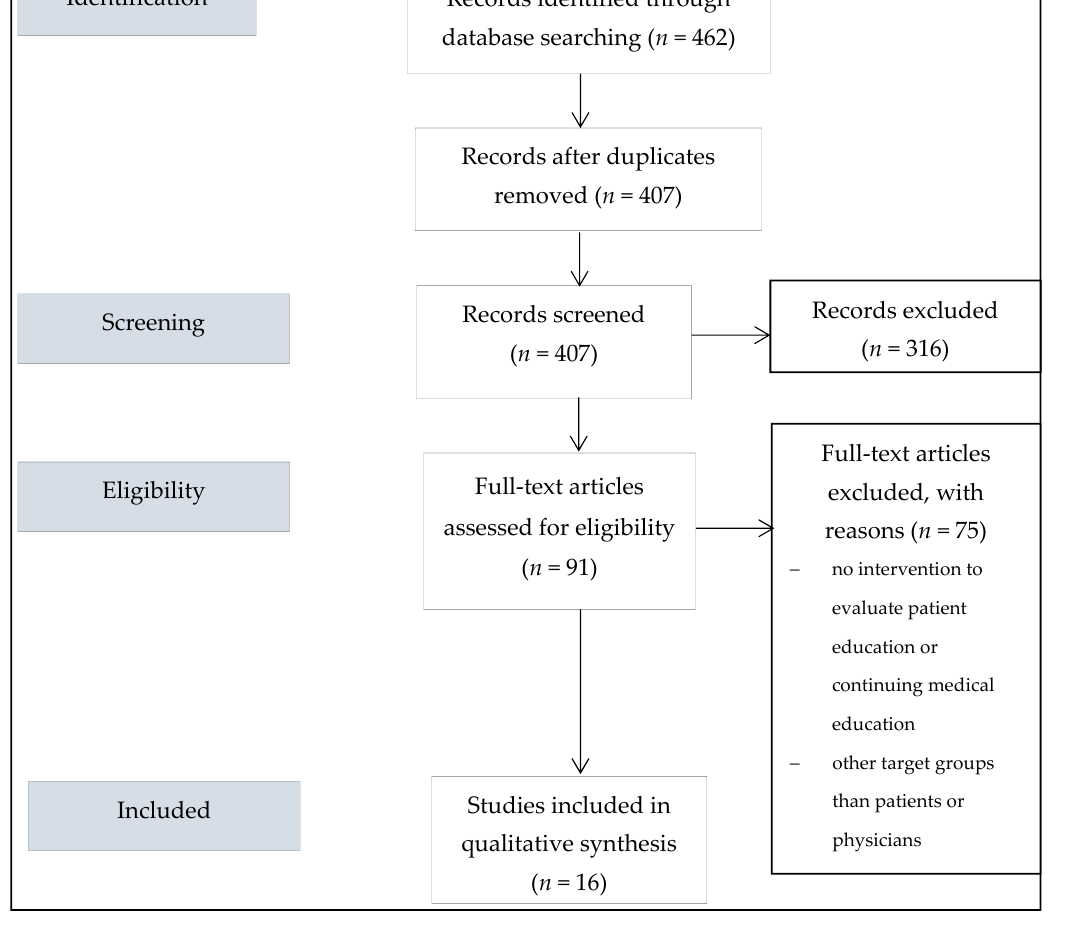
Figure 1 . Study selection. Figure 1. Study